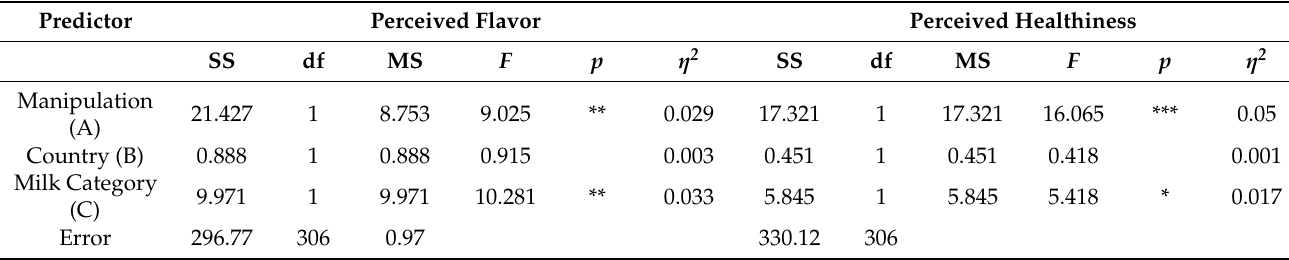
Table 2. Results of the analysis of covariance (ANCOVA).